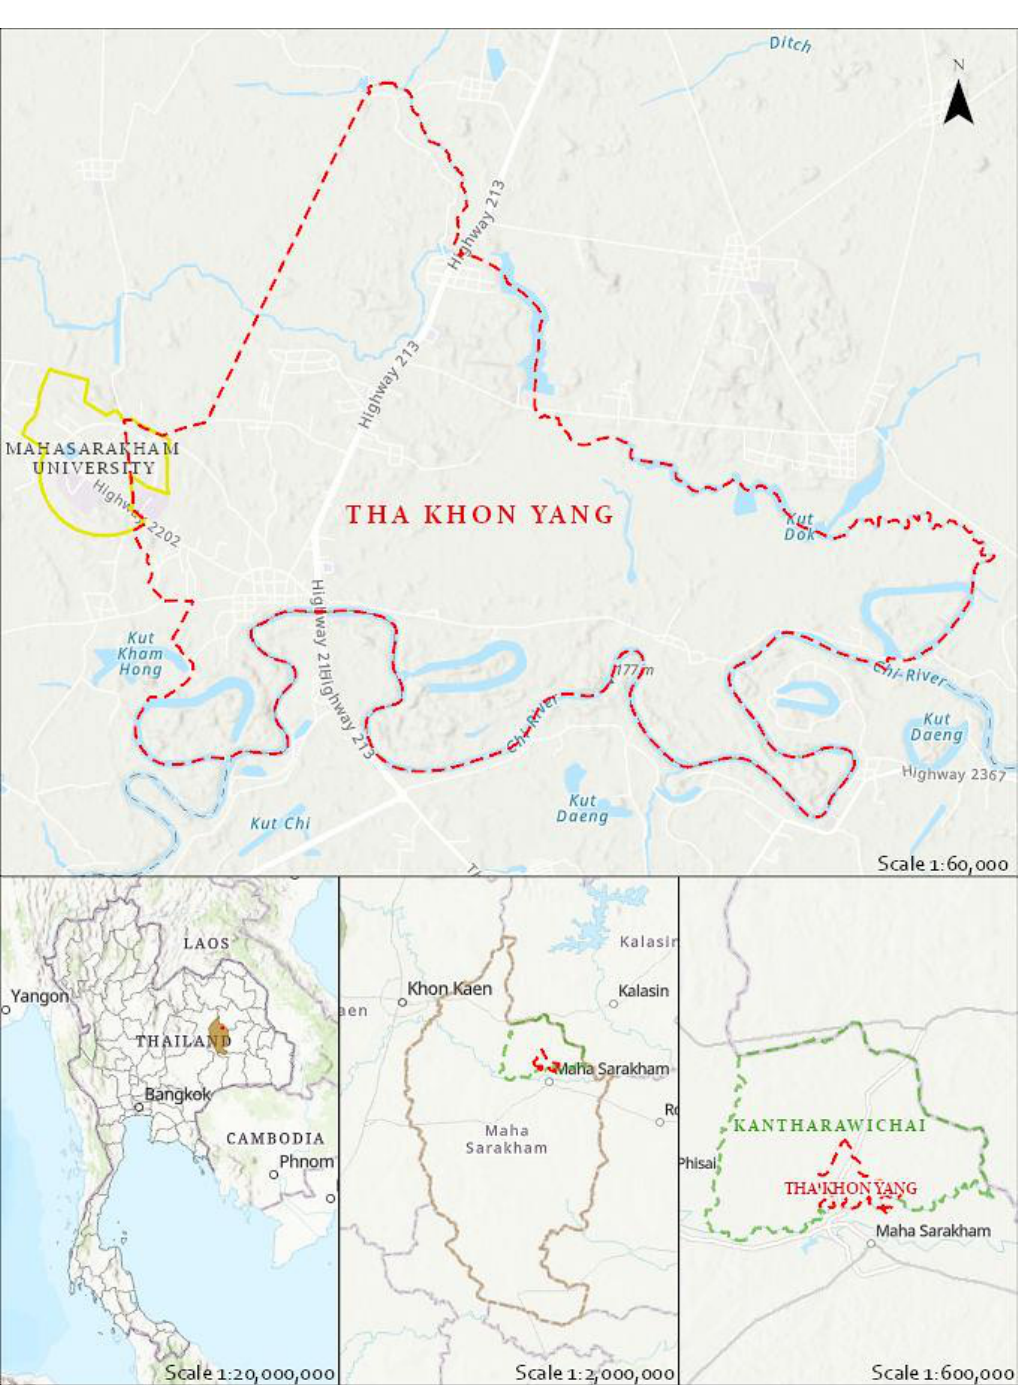
Figure 1. Location of Tha Khon Yang Sub-district in the Maha Sarakham Province in the northeast of Thailand. (Sources: Esri, USGS, NGA, NASA, CGIAR< N. Robinson, NCEAS, NLS, OS, NMA. Geodatastyrelsen, Rijkswaterstaat, GSA, Geoland, FEMA, Intermap and the GIS user community Boundaries: GISTA (Geo-Informatics and Space Technology Development Agency).